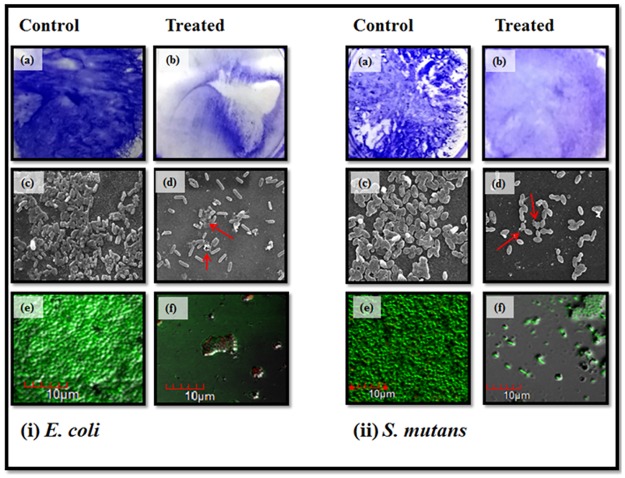
Visualization of the biofilm inhibition [i] Biofilms of E. coli.(a) & (b) images displays control and treated biofilm stained by crystal violet. (c) & (d) images shows the difference in biofilm after treatment as visualized by the SEM. Red arrows indicate the damage in the bacterial cells due to action of AgNPs. (e) & (f) are CLSM images of the control and treated biofilms. [ii] Biofilms of S. mutans (a)& (b) images displays control and treated biofilm stained by crystal violet. (c) & (d) images shows the difference in biofilm after treatment as visualized by the SEM. Red arrows indicate the damage in the bacterial cells due to action of AgNPs. (e) & (f) are CLSM images of the control and treated biofilms.